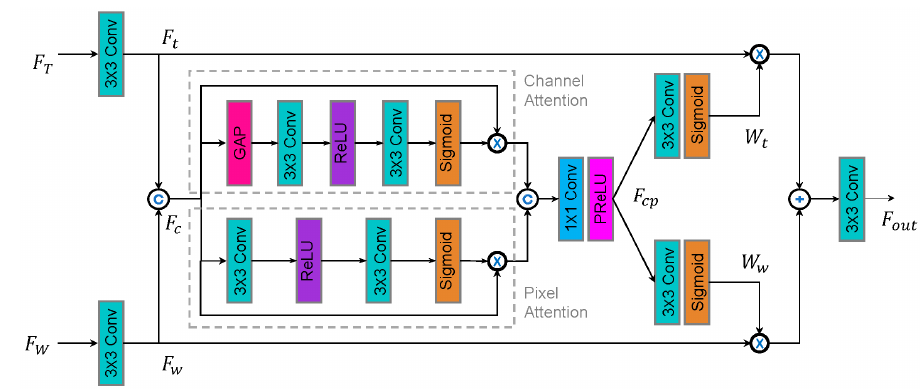
Figure 5. Illustration of the DASFM.